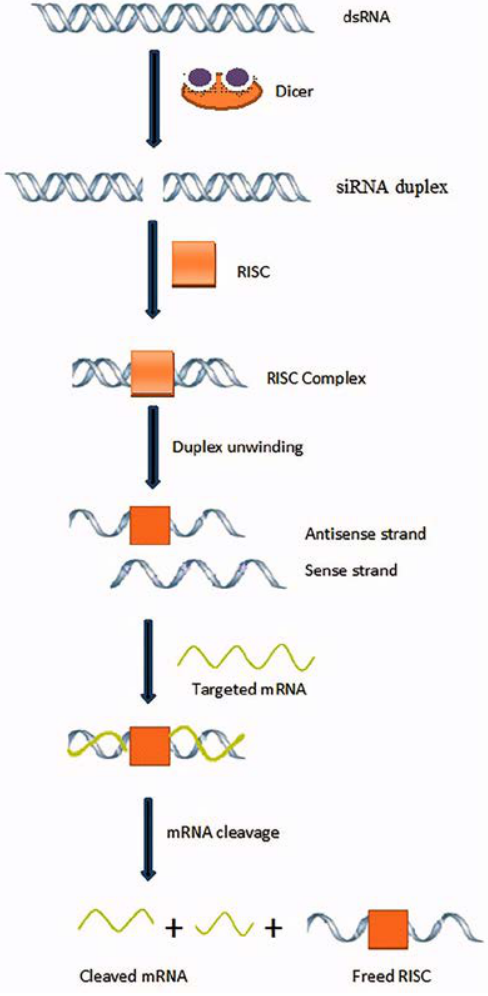
Fig.3 Mechanism of gene silencing using siRNA- based RNAi. Adapted from Alam et al., [31]. Article distributed under creative common attribution (CC-BY)